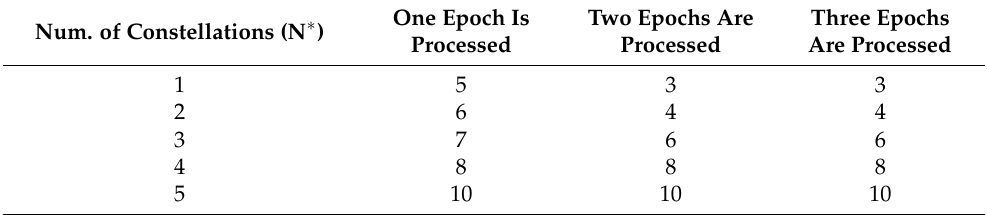
Table 4. Smallest number of (cid:101) M after the PPP models are processed with one, two and three epochs. The symbol N ∗ means the number of existing constellations. Num. of Constellations (N ∗ )